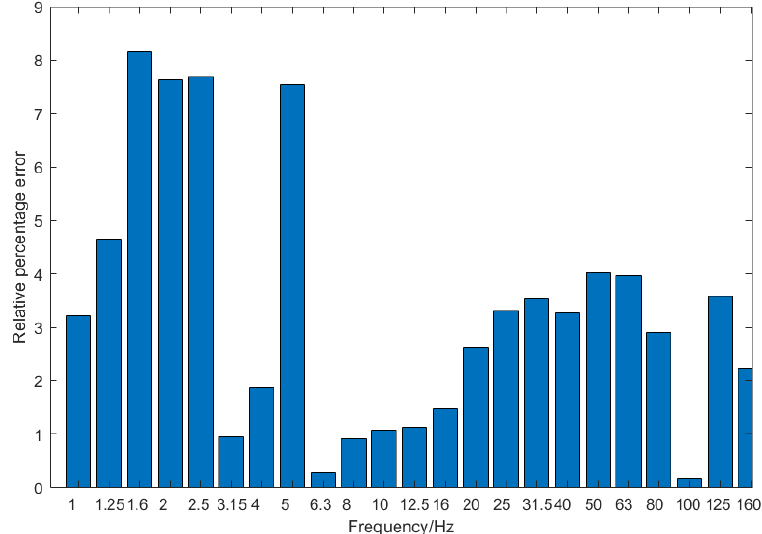
Figure 15. Relative error of the one-third octave spectrum from Channel 7.